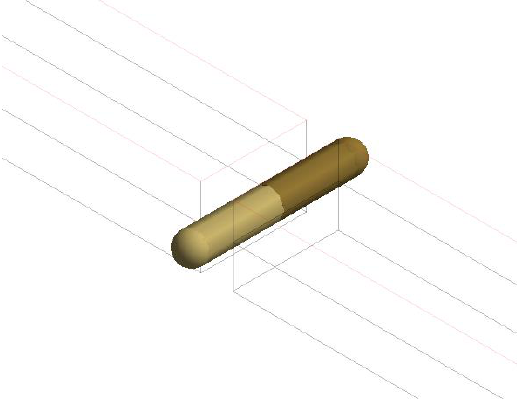
Figure 8. The spring system of a hinged connection.